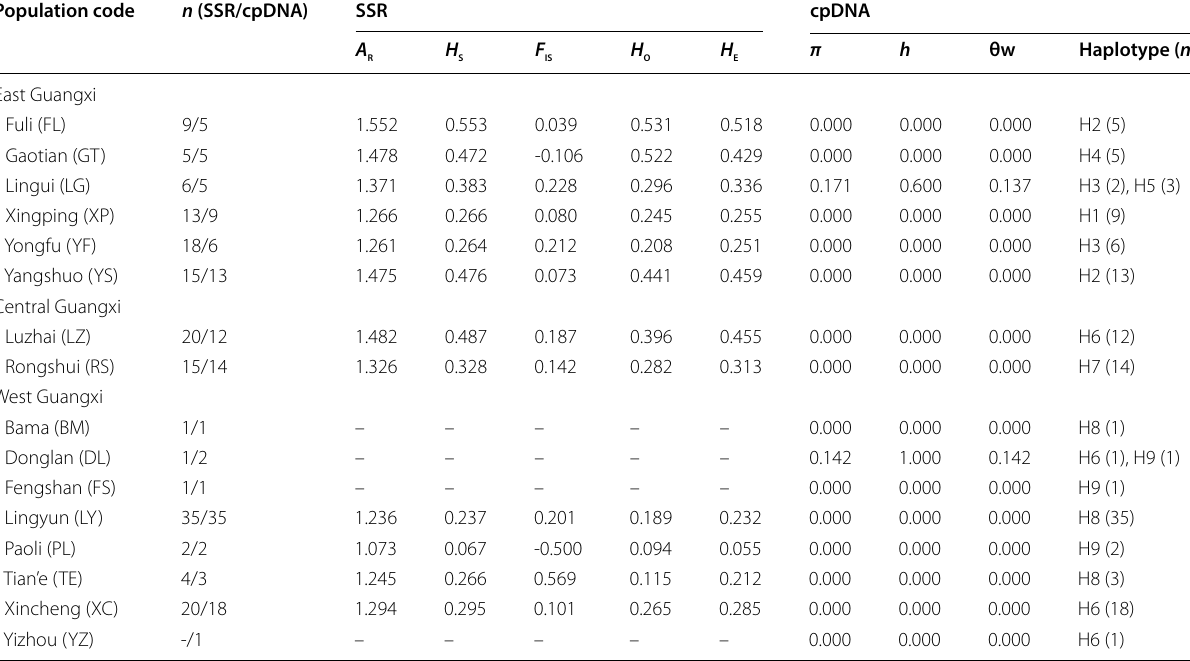
Table 2 Genetic diversity and demographic characteristic of Begonia luzhaiensis based on EST-SSR markers and trnC - ycf6 spacer